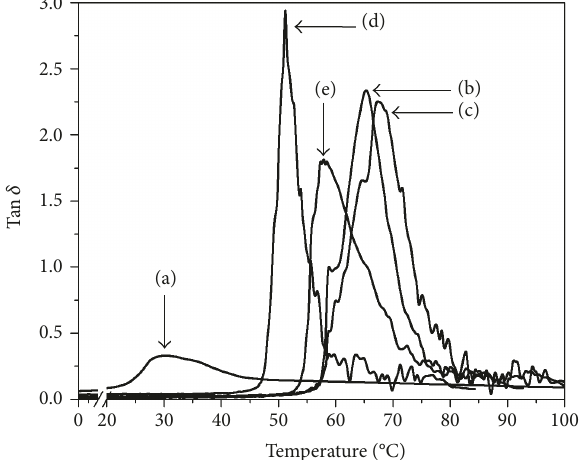
Figure 8: tan 𝛿 of the PLA-PNSP biocomposites: (a) neat PLA, (b) 5% wt. PNSP defatted, (c) 7.5% wt. PNSP defatted, (d) 5% wt. PNSP untreated, and (e) 7.5% wt. PNSP